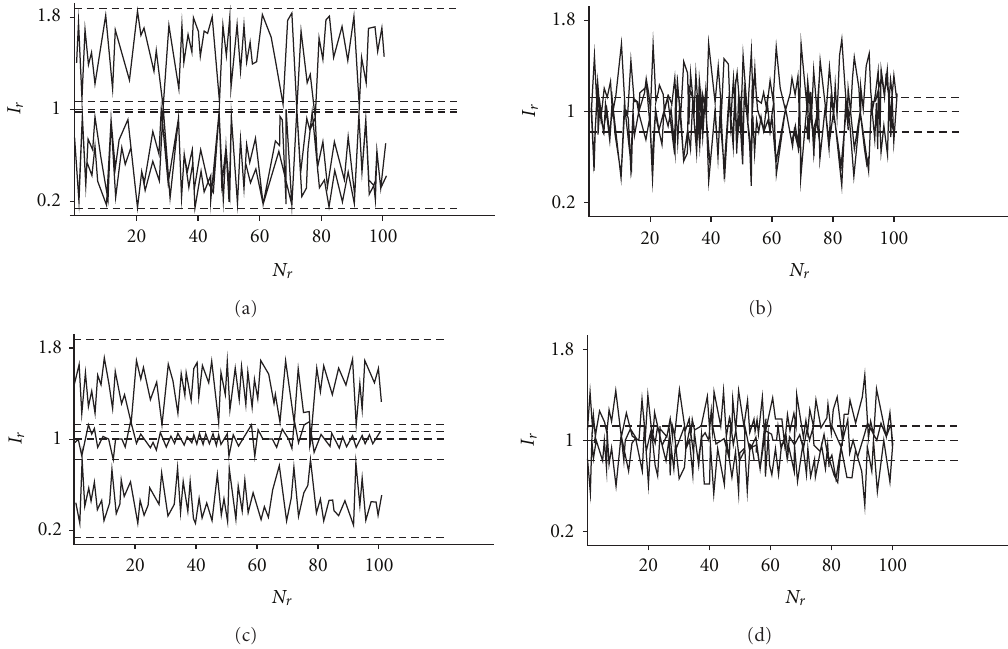
Figure 7: Relative intensity I r calculated numerically with application of di ff erent phase screens N r ( N r ∈ [0,99]). Angles of field rotation Δ = 180 ◦ (a,b) and Δ = 120 ◦ (c, d), Fried’s coherence length L dashed lines correspond to values of I r = 1 . 86 and 0.14. Dashed lines in the central part of the picture correspond to I r = 1 with threshold values of 0.97 and 1.06 (a and c) and to I r = 1 and threshold values of 0.82 and 1.12 (b and